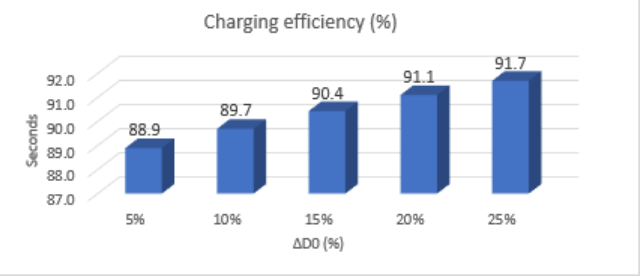
Figure 29. SC circuit charging efficiency diagrams in case of six-phase converter at different ∆ D 0 .